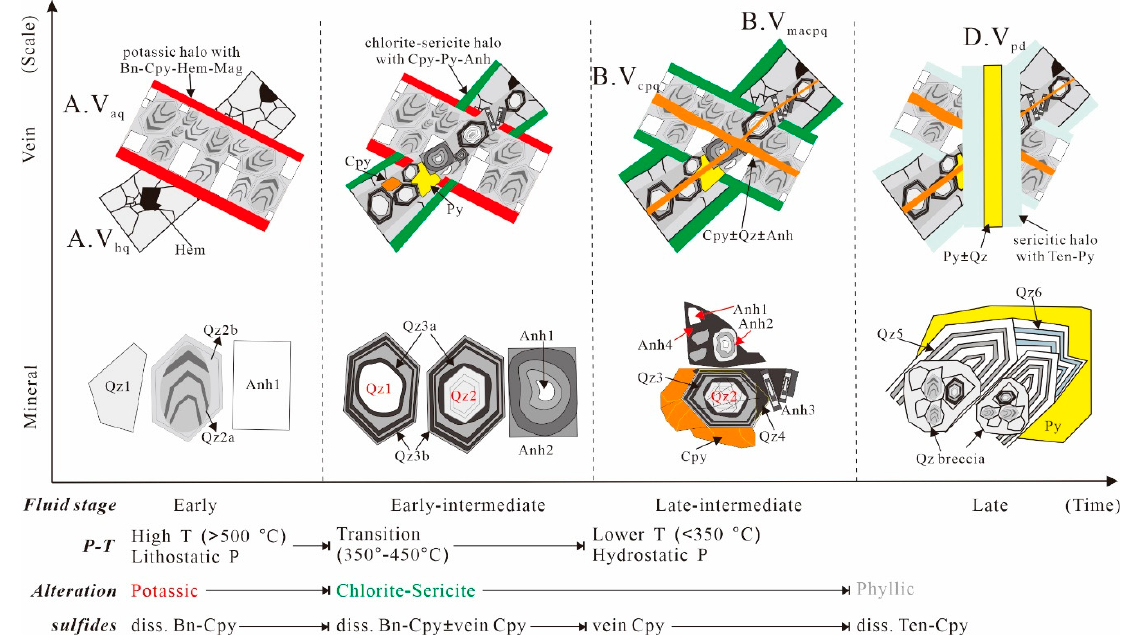
Figure 13. A mineral to vein scale model illustrating hydrothermal alterations, veins, and vein reopening over four fluid stages encompassed in the Tongchang porphyry Cu deposit. It also summarizes the temporal evolution of P-T conditions and sulfide assemblages. Hem: hematite; Bn: bornite; Cpy: chalcopyrite; Mag: magnetite; Qz: quartz; Anh: anhydrite; Py: pyrite; Ten: tennantite; diss: disseminated.